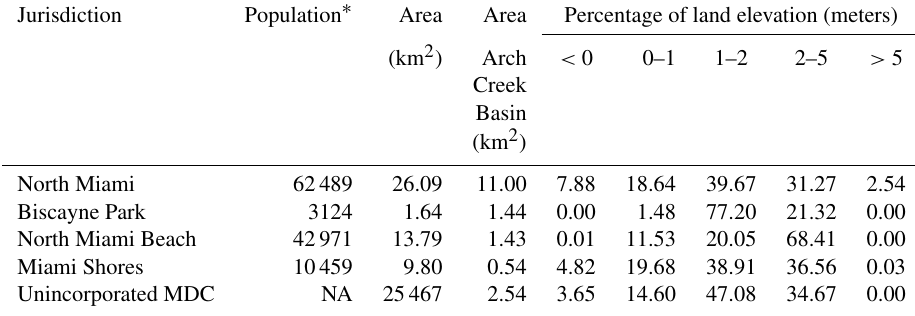
Table 1. Population and land elevations of Arch Creek Basin jurisdictions. Population totals account for the whole jurisdiction area (US Cen- sus Bureau,